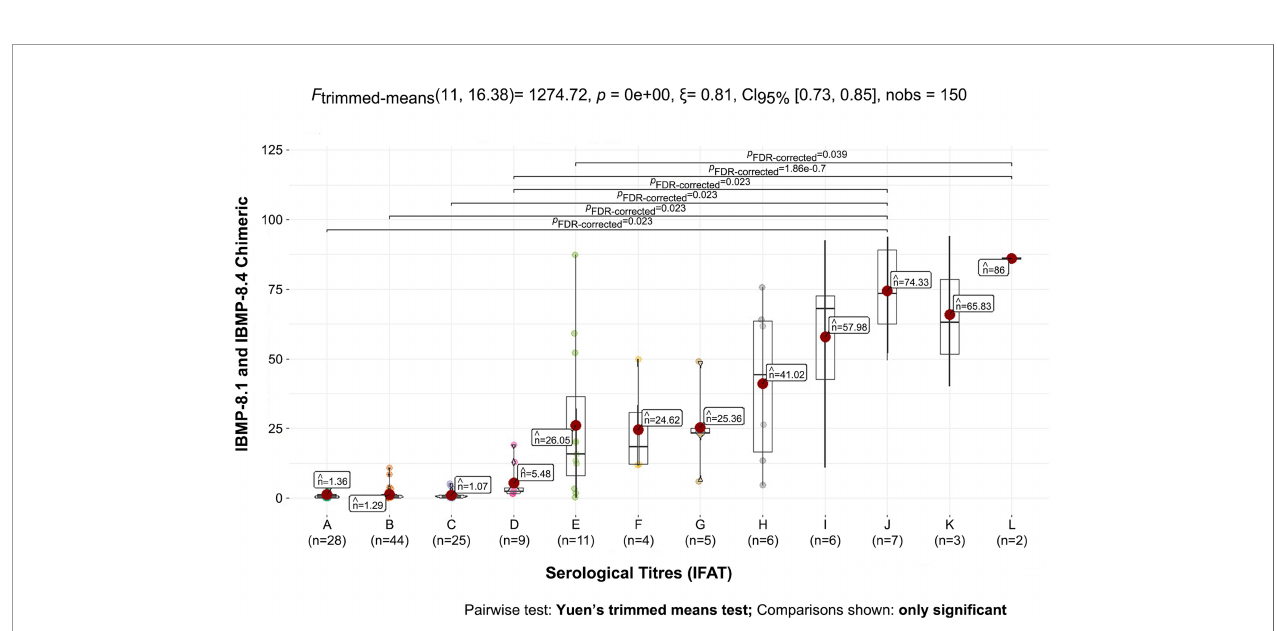
FIGURE 4 | Mean of negative and positive samples from dogs infected by Trypanosoma cruzi against the chimeric antigens IBMP-8.1 and IBMP-8.4. Number of samples (n) and mean optical densities obtained by serological titer (A - negative, B - 1/10, C - 1/20, D - 1/40, E - 1/80, F - 1/160, G - 1/320, H - 1/640, I - 1/1280, J - 1/2560, K – 1/5120, L –